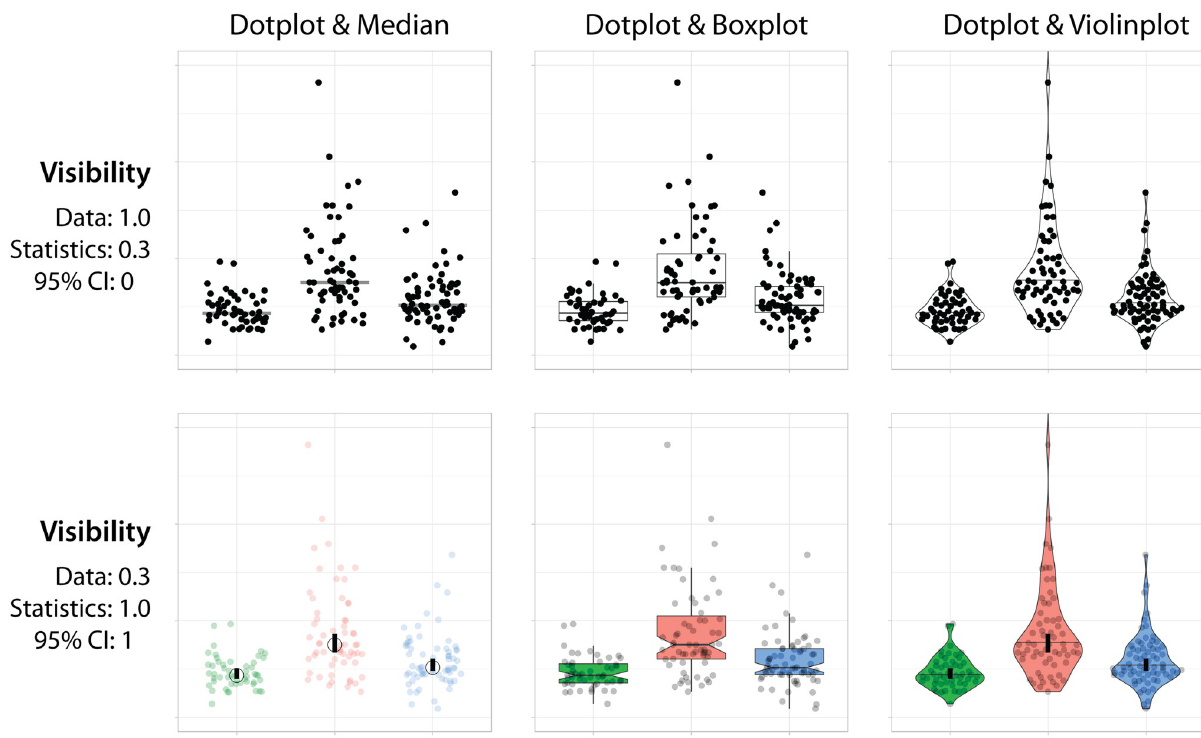
Fig 2. An overview of data visualizations generated using PlotsOfData. The sample data that are available in PlotsOfData are presented together with statistics in different ways. Upper row, a data-centered presentation, with prominent display of the data as dot plots and the statistics displayed with a visibility of 0.3. Lower row, a statistics-centered presentation that shows the data at lower visibility (0.3) and prominently shows the statistics and the 95CIs. Horizontal lines (or a circle in the lower left panel) display the median value, and vertical bars show the 95CI. For box plots the 95CI is indicated by notches. 95CI, 95% confidence